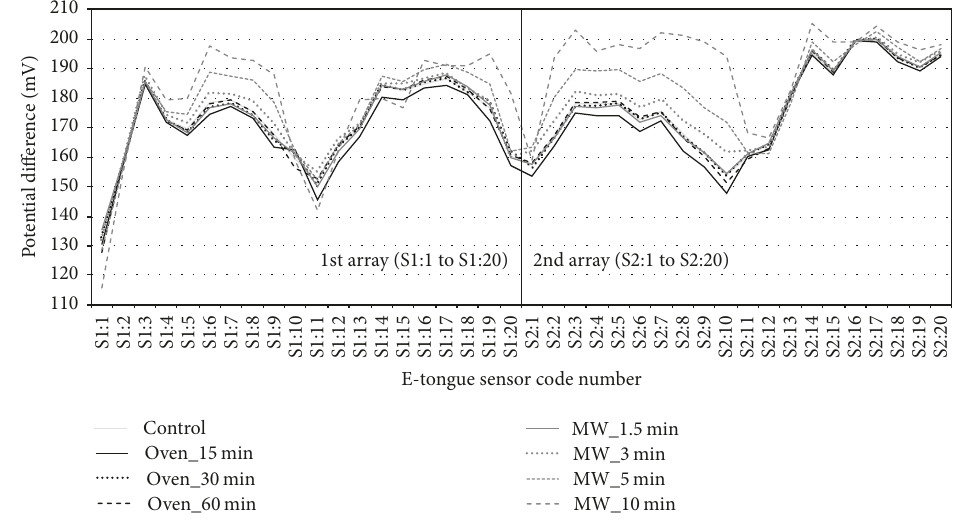
Figure 4: E-tongue potentiometric mean signal profiles recorded during the analysis of hydroethanolic unheated (Control) and heated olive oils in an oven (2000 W) during 15, 30, or 60 min (Oven 15 min, Oven 30min, and Oven 60min) or in a microwave (1200 W) during 1.5, 3, 5, or 10min (MW 1.5 min, MW 3min, MW 5 min, and MW 10 min).